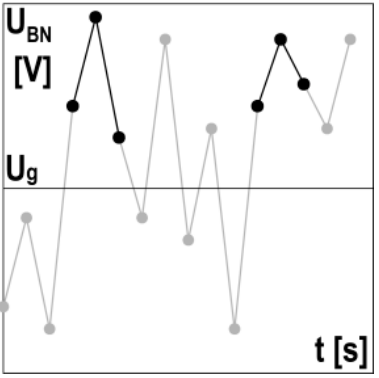
Figure 4. Method of event determination above the set value of threshold voltage U g.